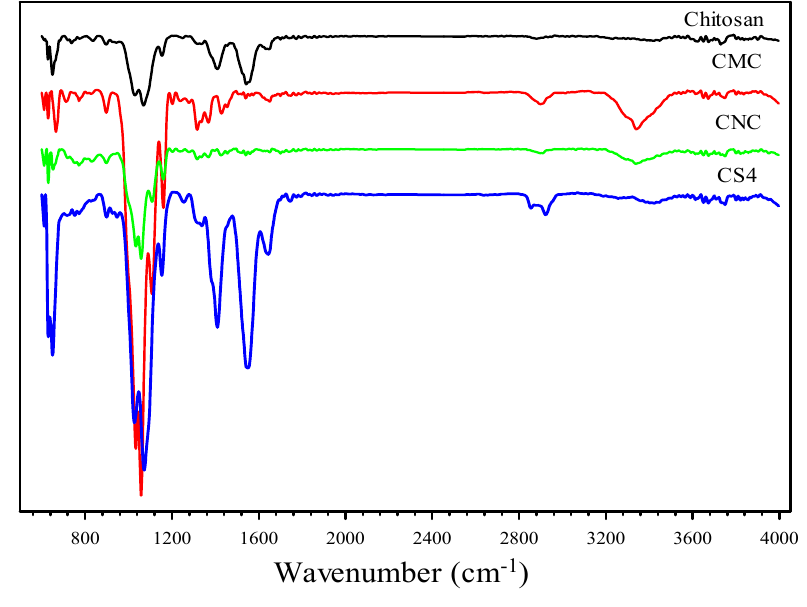
Figure 2. FTIR of CS, CMC, CNC, and CS4 samples.